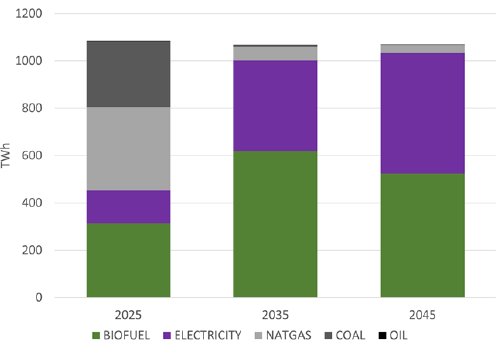
Figure 4. Aggregated heat production per fuel for the countries in focus (countries shown in Fig. 2). The industrial sector and individ- ual users connected to district heating are included.